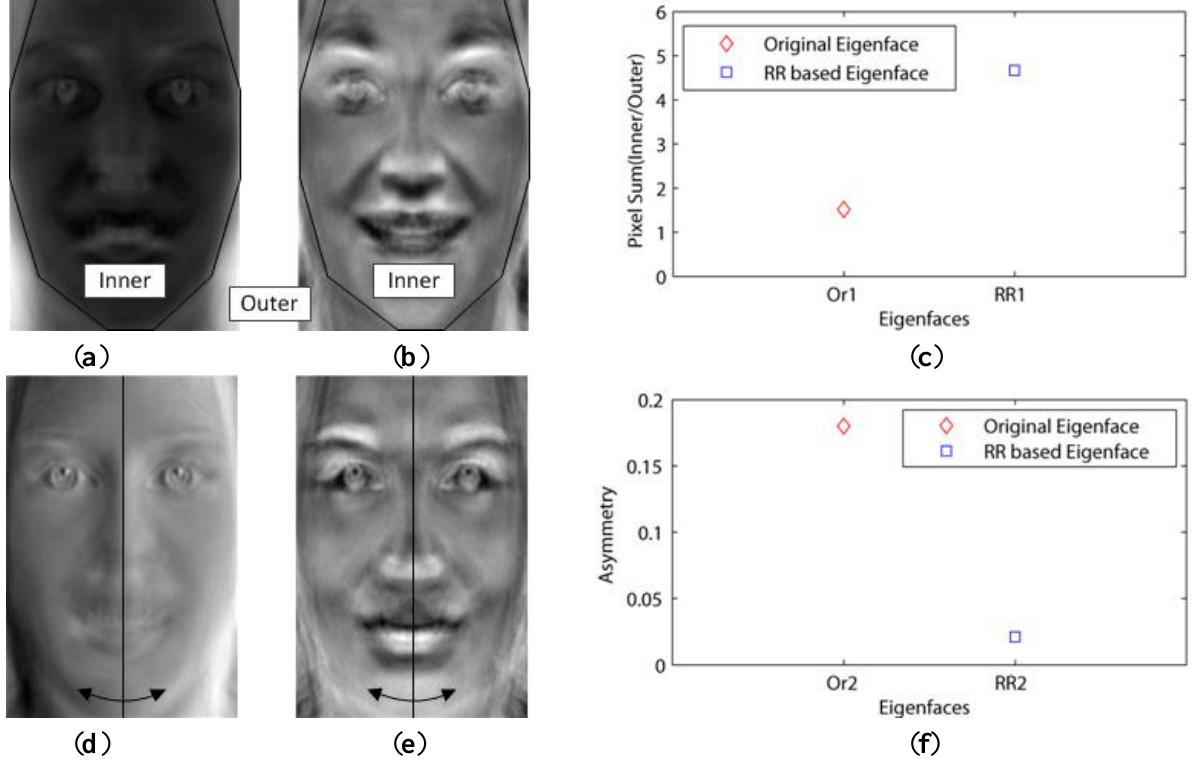
Figure 3. Comparison of eigenfaces chosen by U and eigenvalue: ( a ) First basis face with a large eigenvalue (Or1); ( b ) First basis face with a small U (RR1) ; ( c ) Pixel summations between inner and outer faces; ( d ) Second basis face with a large eigenvalue (Or2); ( e ) Second basis face with a small U (RR2); ( f ) Eigenface asymmetry between Or2 and